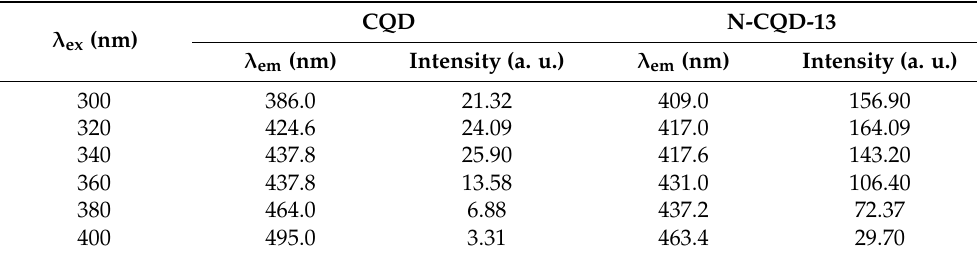
Figure 5. Fluorescence emission and normalized fluorescence spectra of the CQD ( a ) 80 mg/L and N-CQD-13 ( b ) 80 mg/L collected at different excitation wavelengths ranging from 300 to 400 nm. Table 8. Maximum emission wavelengths ( λ em ) and intensities of CQD and N-CQD-13 excited at different excitation